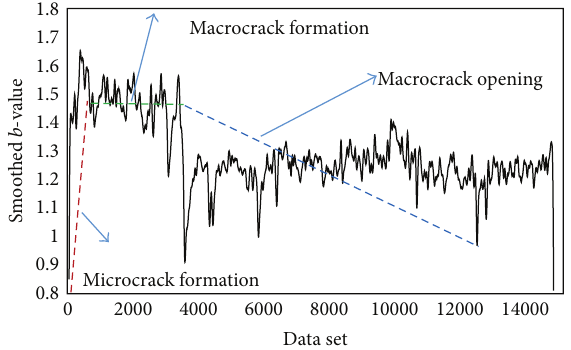
Figure 12: Smoothed 𝑏 -values results for entire data set of TC